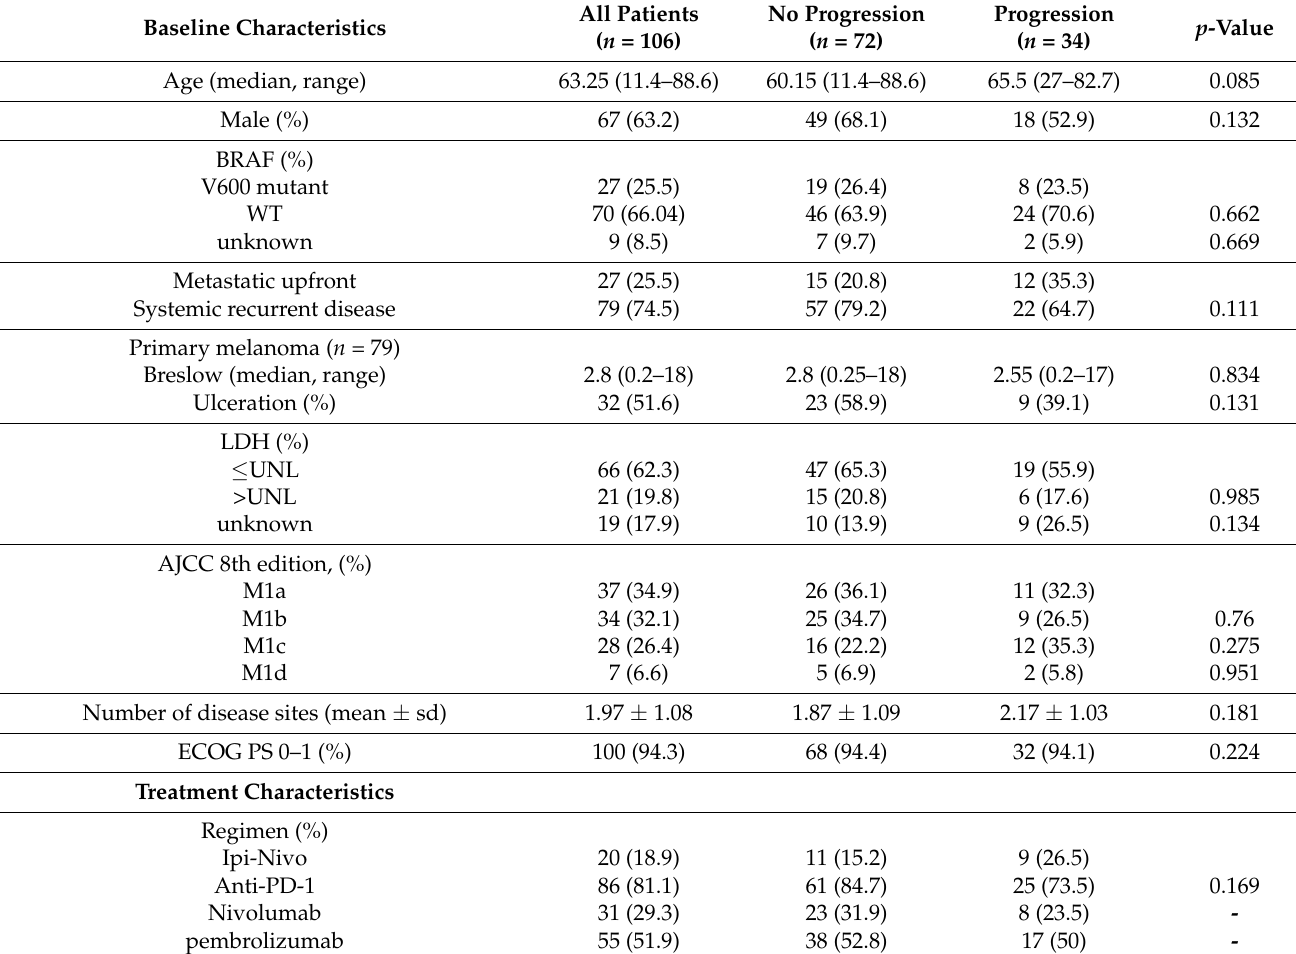
Table 1. Baseline patient